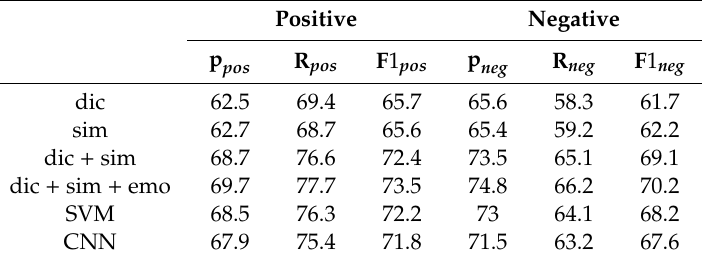
Table 4. Comparisons of di ff erent methods’ outcomes.